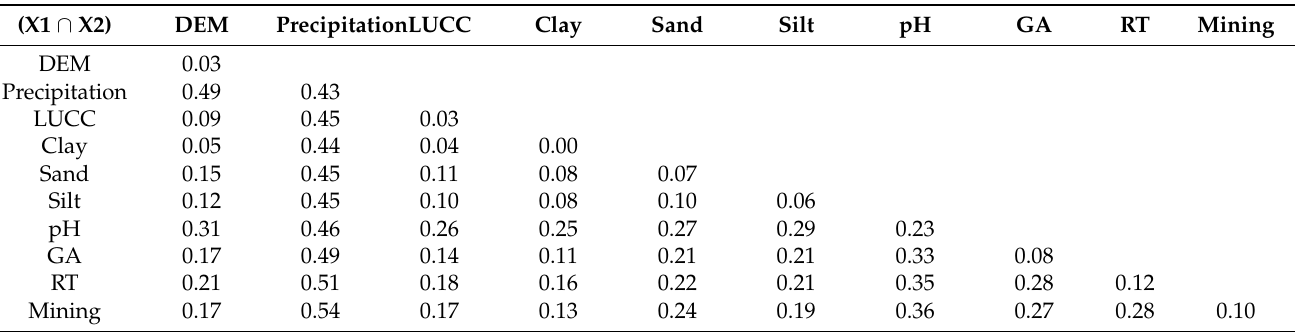
Table 8. Effects of the interaction between each pair of driving factors on the enrichment of the Cr concentration in the YTRB.